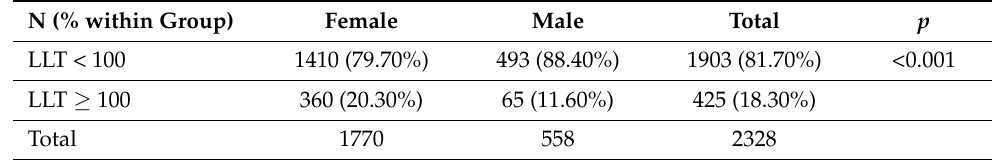
Table 6. Distribution of high LLT in females and